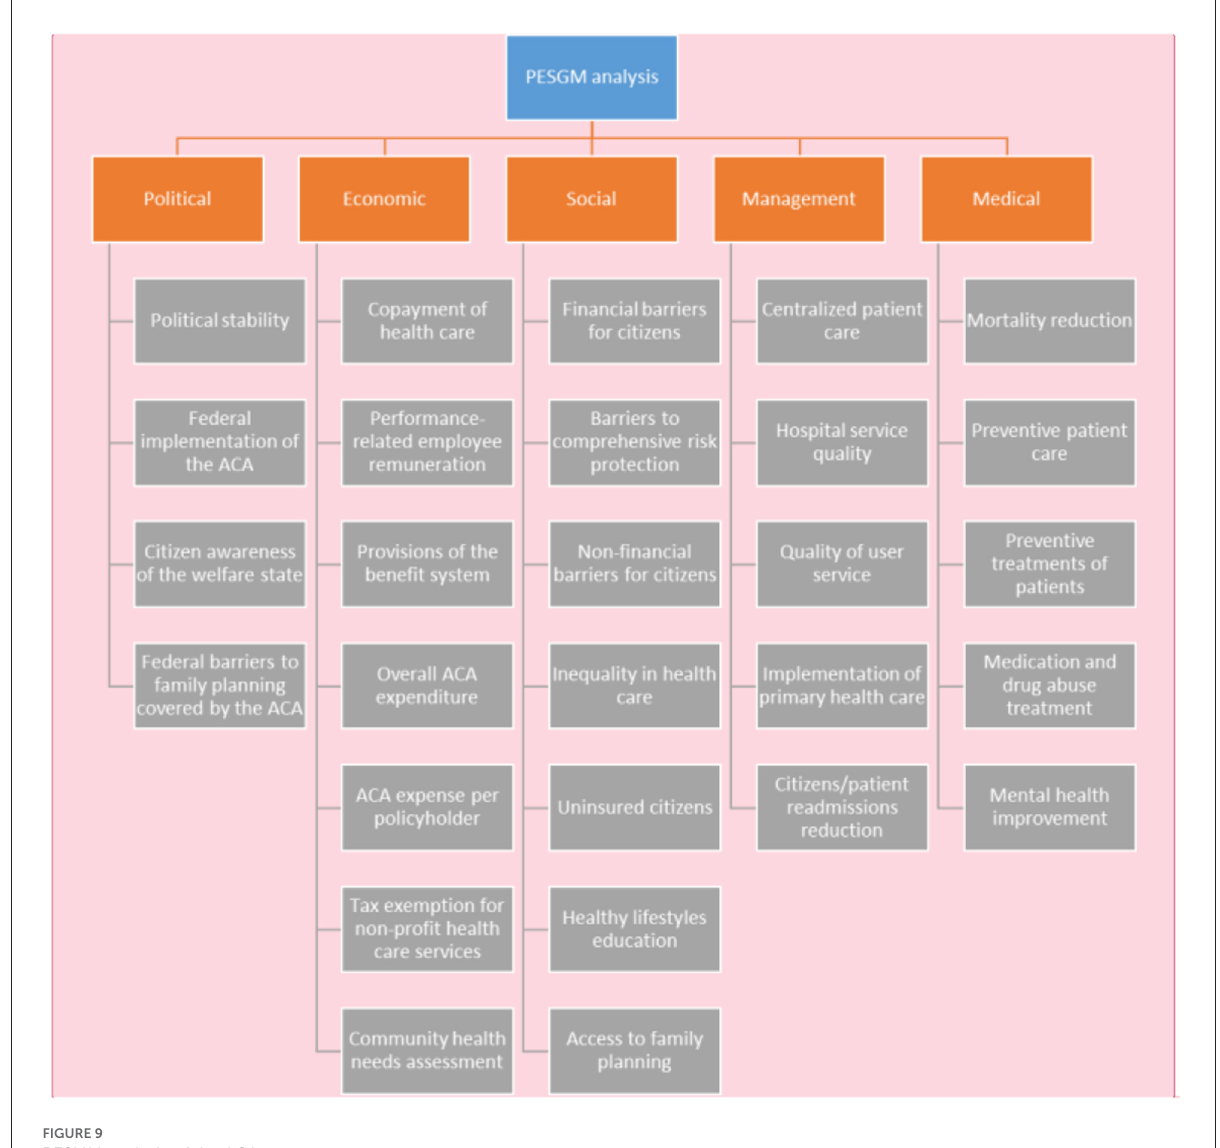
FIGURE9 PESMM analysis of the